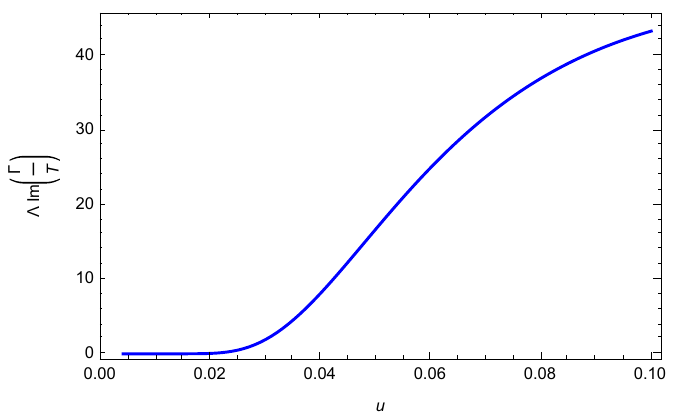
Figure 1. Imaginary part of the effective action as a function of the atom velocity u (dimensionless in natural units). There is no dissipative effect until u > v F = 0.003, and QF increases as the parallel speed of the atom grows. We set Λ = 8 a 3 m Ω / ( π e 2 α N ) and Γ